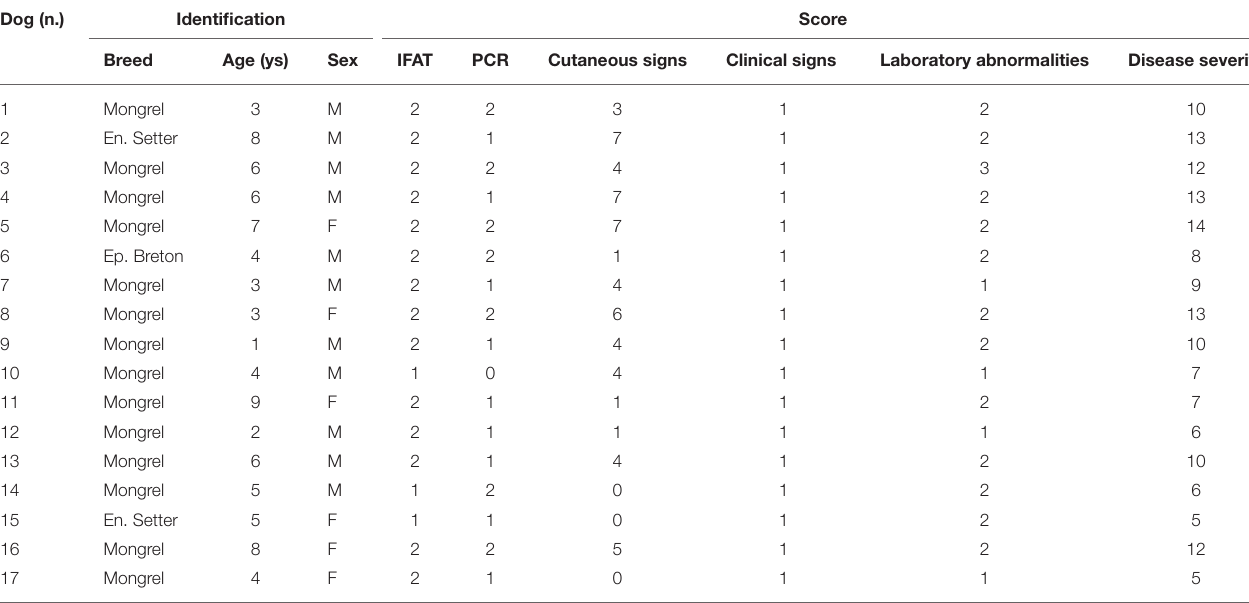
TABLE 2 | Breed, age, sex, and disease severity of the enrolled dogs. Dog (n.) Identification Score Breed Sex IFAT PCR Cutaneous signs Clinical signs Laboratory abnormalities Disease